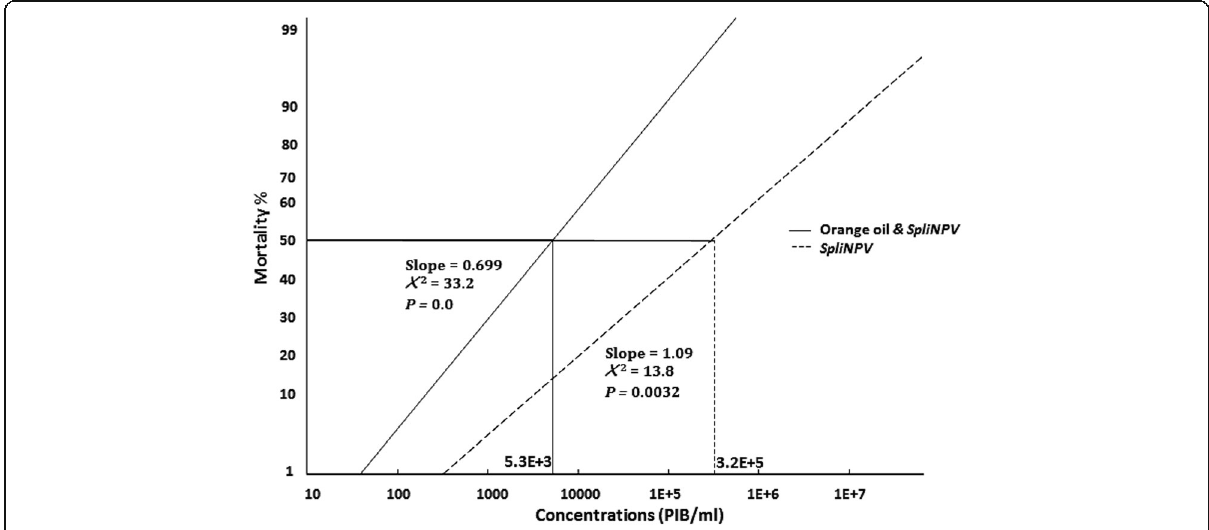
Fig. 3 Effect of orange oil on the Spli NPV pathogenicity against Spodoptera littoralis